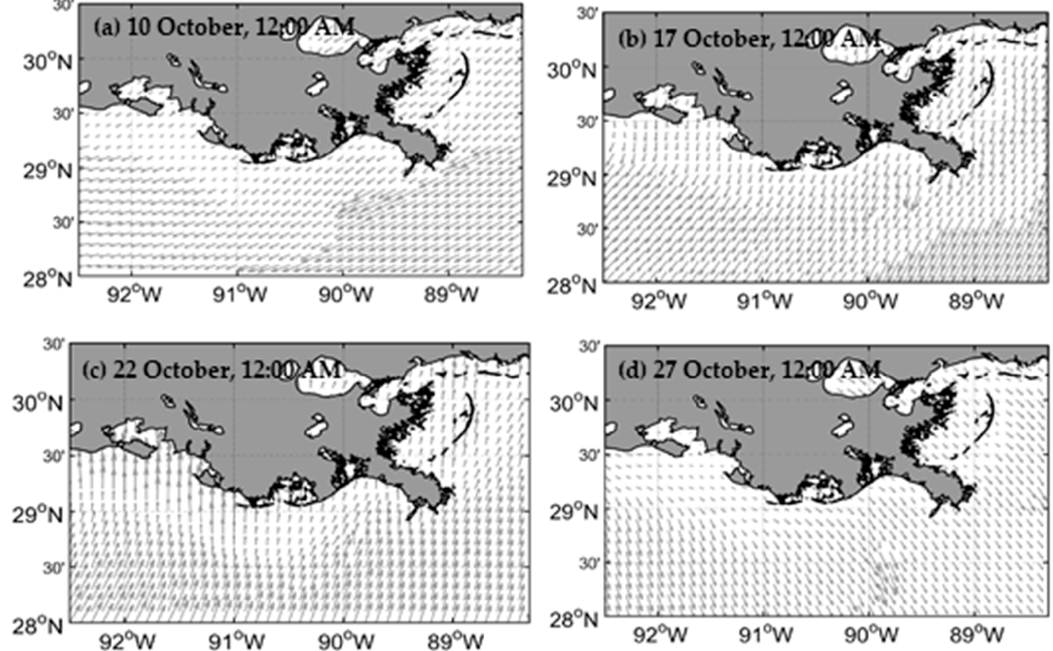
Figure 7. Simulated wind-induced surface currents over the Louisiana shelf during and after different cold front events, ( a ) 10 October 12:00 a.m., ( b ) 17 October 12:00 a.m., ( c ) 22 October 12:00 a.m., ( d ) 27 October 12:00 a.m.